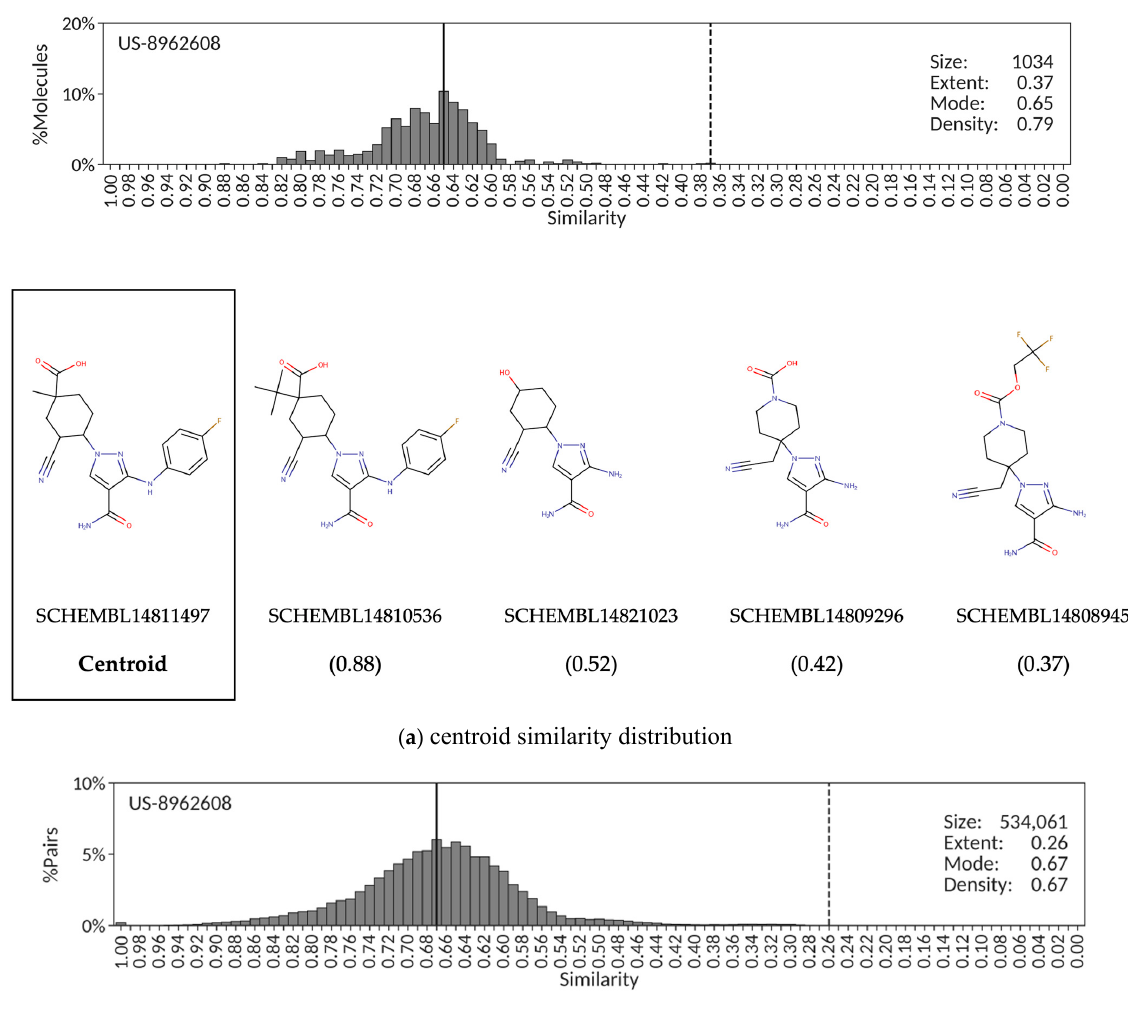
Figure 3. Centroid ( a ) and all pairwise ( b ) similarity distributions for the set of molecules exemplified in SureChEMBLccs patent US-8962608. Additionally, included ( a ) is a sample of chemical structures with their SCHEMBL identifiers and similarity values (in parenthesis). The extent and mode are indicated, respectively, by vertically dashed and solid lines.